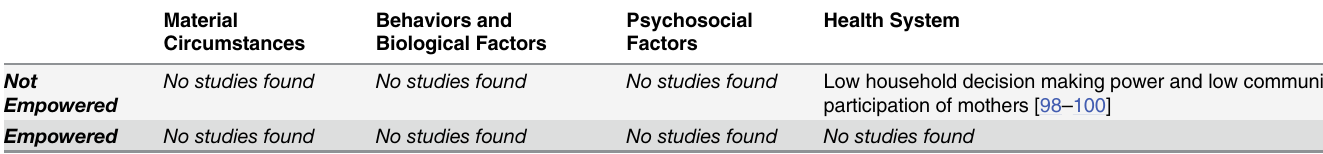
Table 4. Gender Empowerment and Child Health in Indonesia.